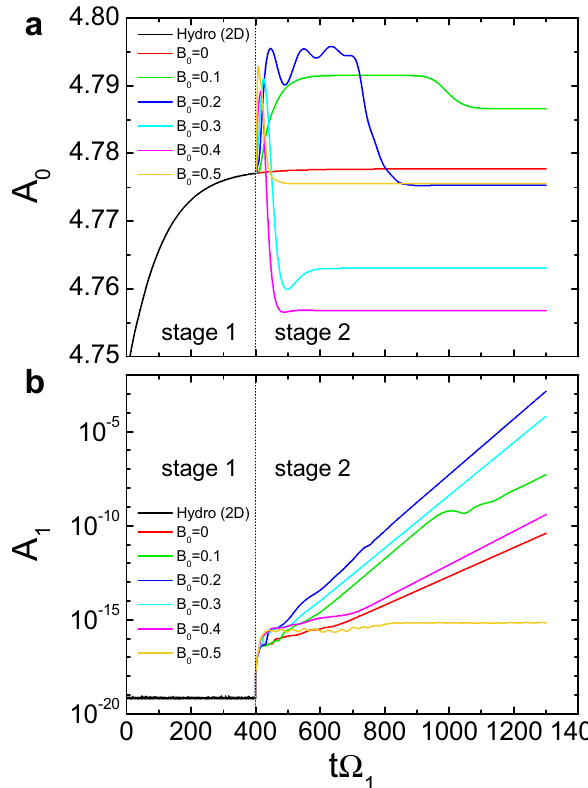
Fig.4|Timeevolutionof2-modesimulation. Simulateddimensionlessamplitude m =0mode ( a )and A m =1mode( b )inthetotalvelocity fi eld,asa A 0 ofthe 1 of the functionofthedimensionlesstime t Ω 1 fordifferentvaluesof B 0 at fi xedRm=4.The calculationisbasedonvolumeaverageoverthe fl uiddomain.Verticaldashedlines show the time boundary between the fi rst and second